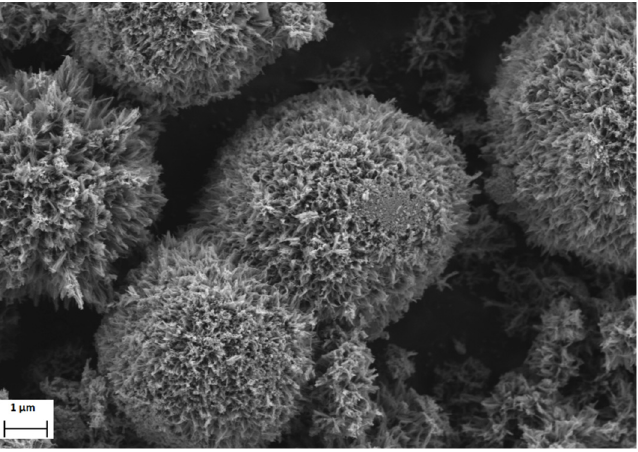
Figure 8. SEM images of sample A after 3 photocatalytic experiments.